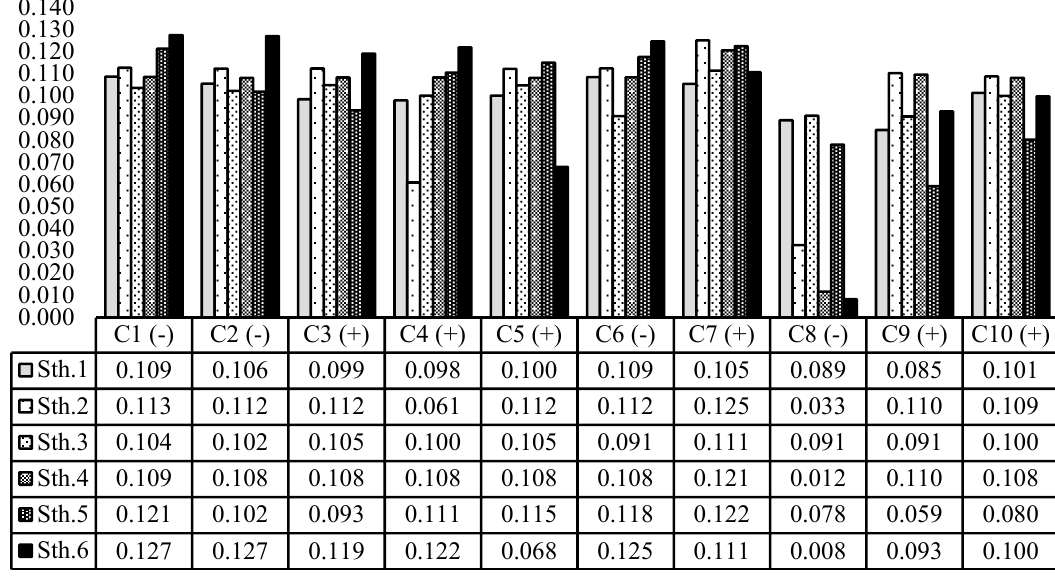
Figure 8. The final weights of the selected criteria in each individual stakeholder’s viewpoint. The final criteria weights in the group viewpoint are represented in Figure 9.